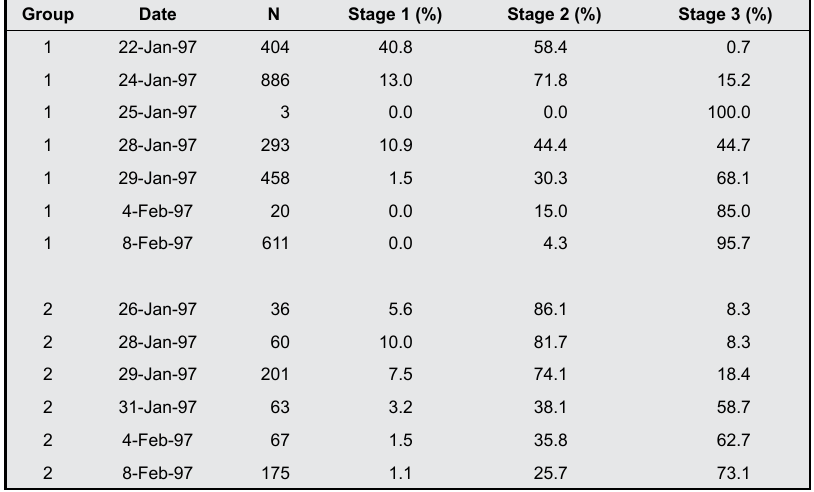
Table 5 . Proportion of pups in various age-dependent developmental stages during the 1997 Southern Gulf surveys. Group 1 applies to surveys flown